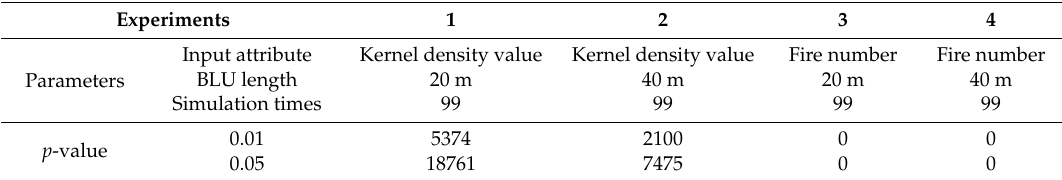
Table 3. Parameters and H-H segment numbers in experiments of